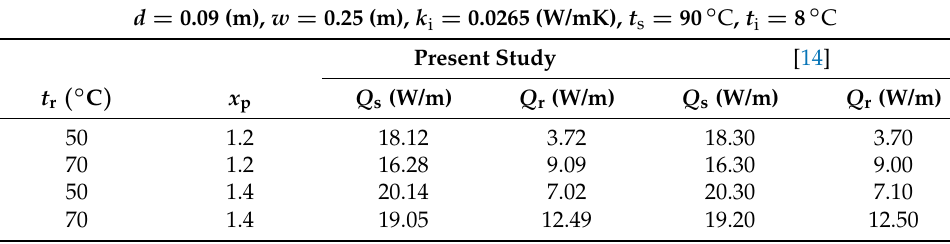
Table 3. Comparison of the present solutions with the numerical data provided by Krawczyk and Teleszewski [14] for a pre-insulated double-pipe system.